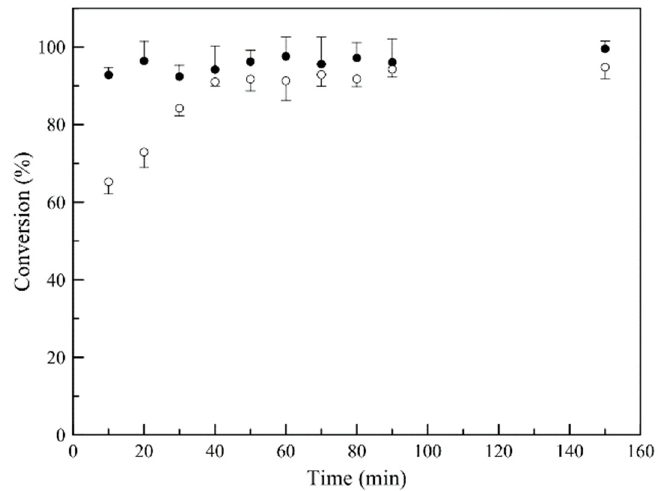
Figure 3. Monomer (MMA) conversion versus time, for P(MMA-TEGDMA) nanoparticles ( ● ) and D-limonene, loaded P(MMA-TEGDMA) nanoparticles ( ◦ ) synthesis.